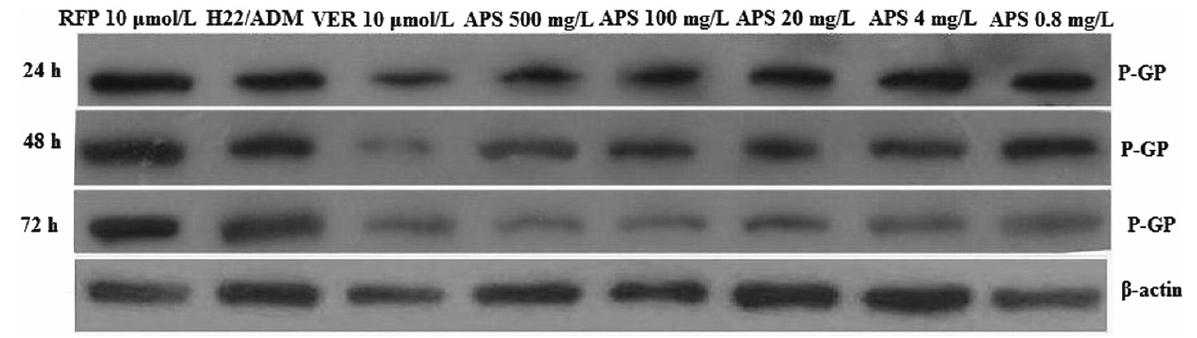
Figure 3 P-GP expressions in H22/ADM cells after exposure to the different chemotherapy agents at different time points (24 h, 48 h, and 72 h).